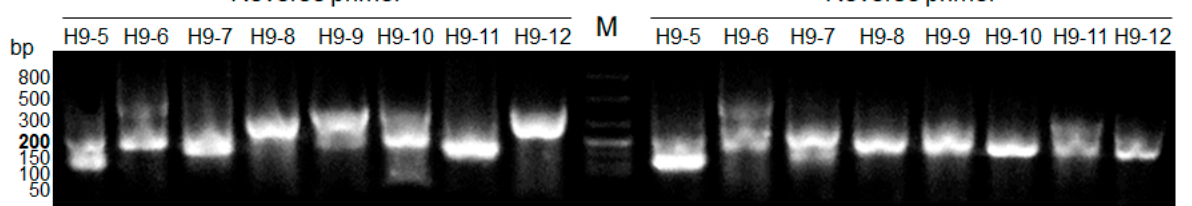
Figure 3. Partial electrophoretic results after amplification of the second library during the RDV method. In this amplification, H1–3 were used as forward primers, and H9–5 to H9–12 were used as reverse primers. Lane M, FlashGel™ DNA Marker, 50 bp–1.5 kb. Table 2. Reads detected using the RDV method. Read Detail Read